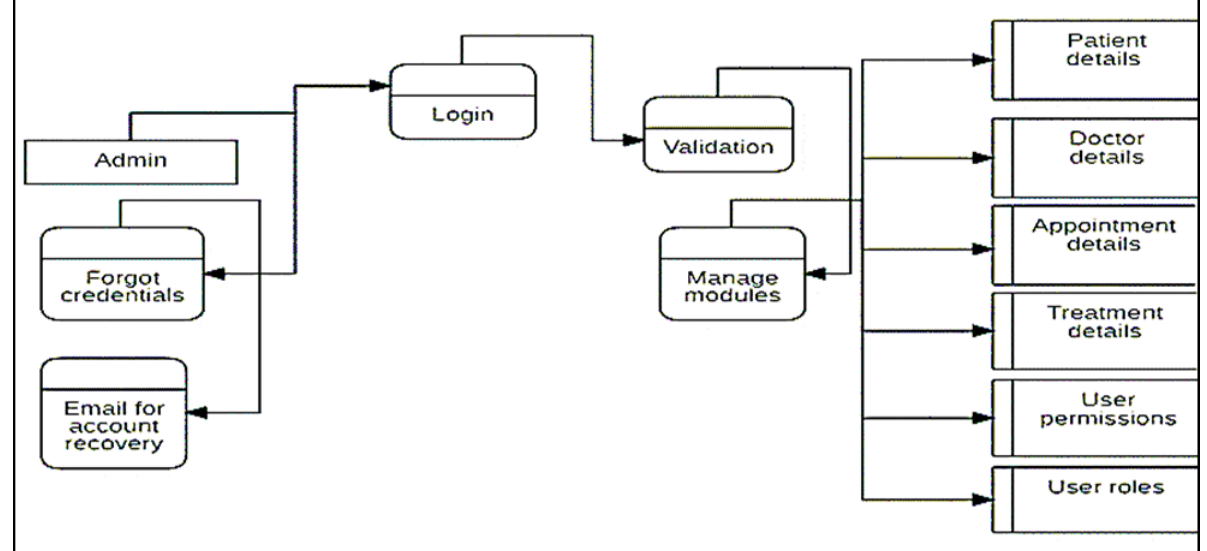
Fig. 1. Architecture diagram of